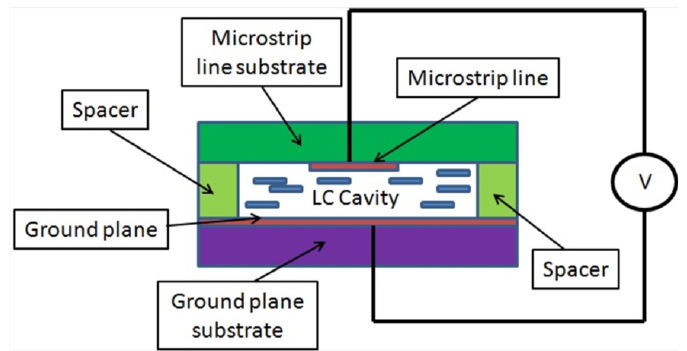
Figure 2. An inverted-microstrip structure for a LC bandpass filter. The detail of the parts of the filter is shown. Note that figure is not drawn to scale.